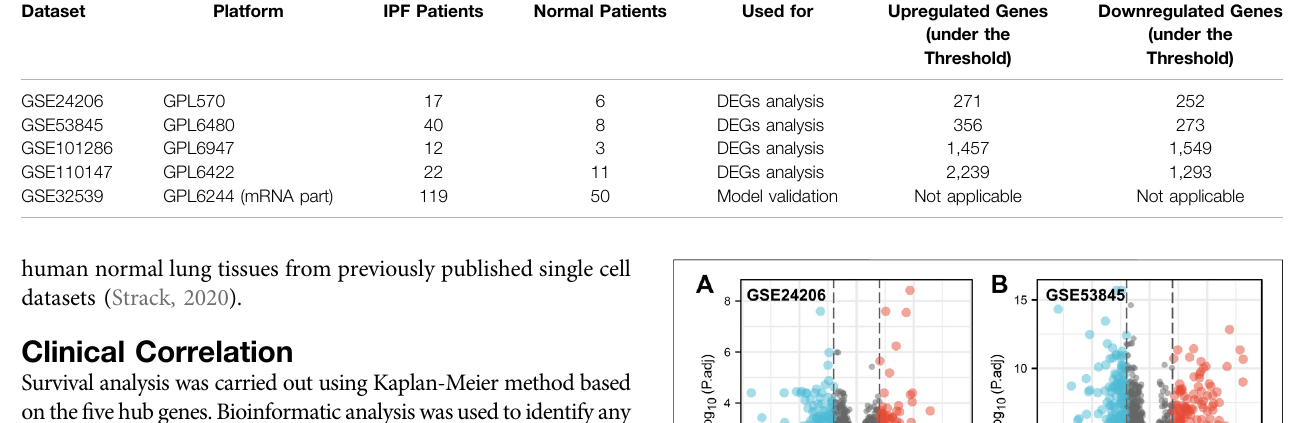
TABLE 1 | The overview of the dataset used for this study. Dataset